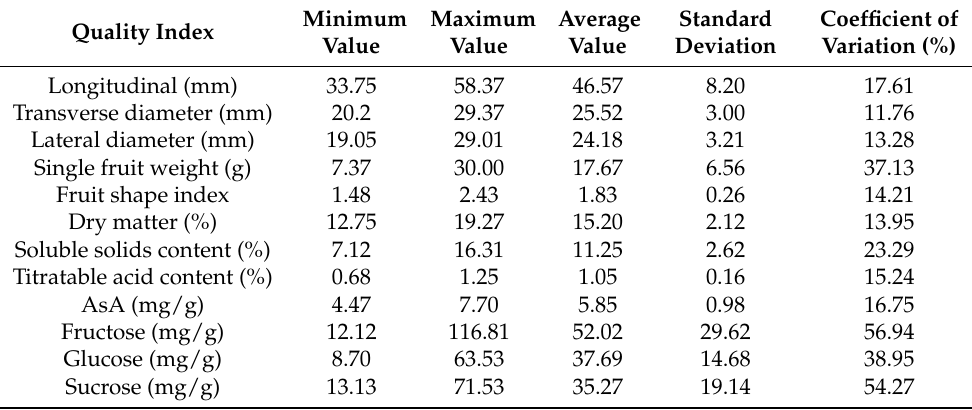
Table 2. The variation analysis of fruit quality indexes of wild A. eriantha . Quality